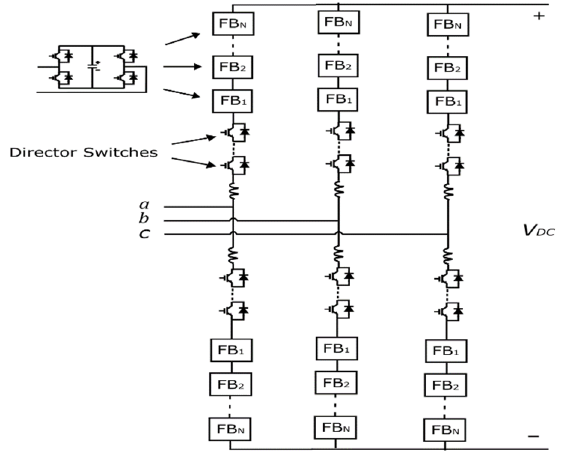
Figure 22. Figure 22. AAC.